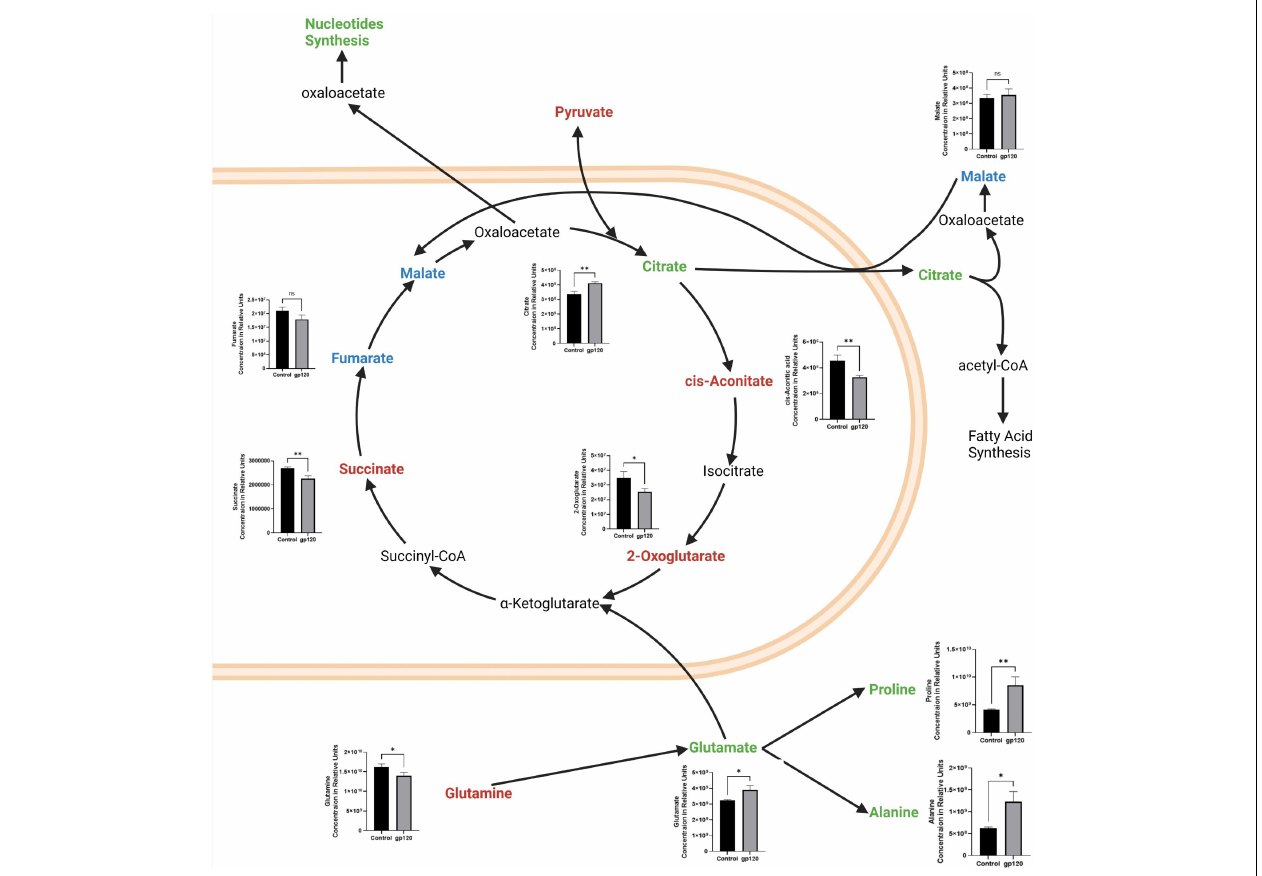
FIGURE 3 | Alterations in the TCA cycle and glutaminolysis pathway after gp120 treatment. TCA cycle and glutaminolysis pathway metabolites that are upregulated (green), downregulated (red), and not significantly changed (blue) in LUHMES treated with gp120 compared to control cells. Graphs show changes in the associated TCA cycle and glutaminolysis pathway metabolites in control and gp120 treated LUHMES. Bar Graphs black bars are control samples, gray bars are gp120 treated samples (* p < 0.05, ** p <